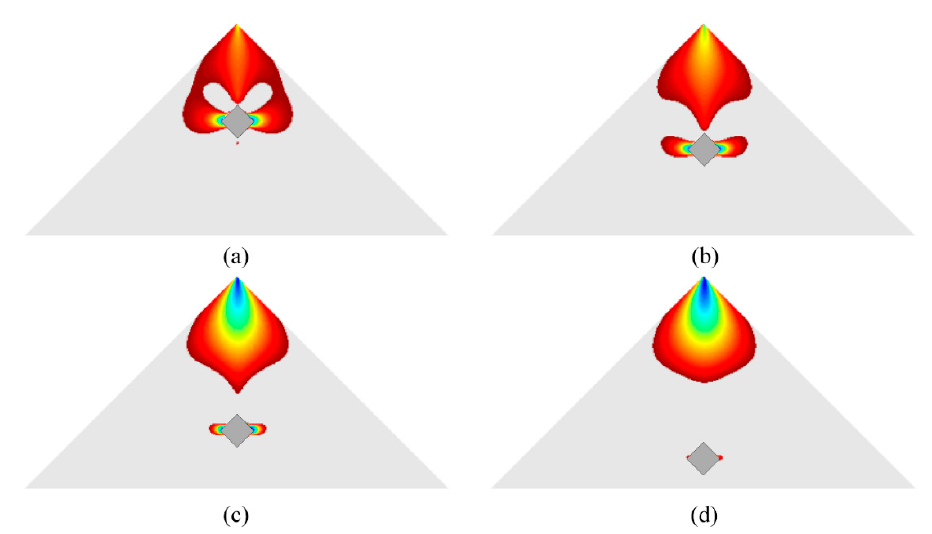
Figure 3. Compressive-stress area of the membrane: ( a – d ) indicate that the positions R c of the rigid elements are 30 mm, 40 mm, 50 mm, and 60 mm, respectively.